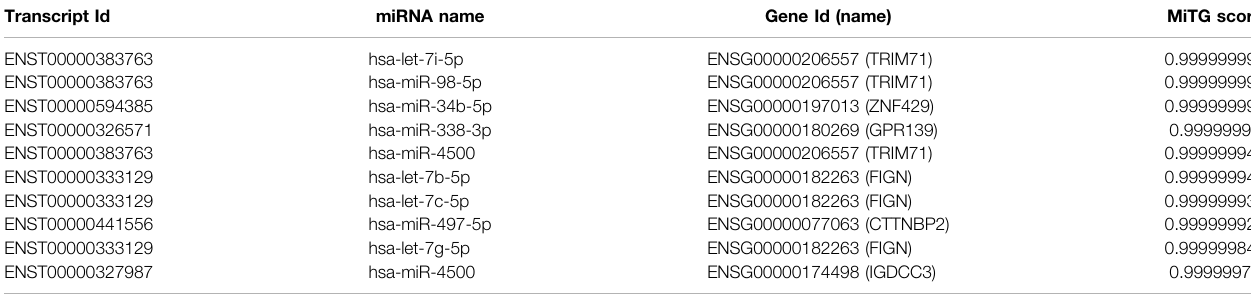
TABLE 2 | Targeted messenger RNAs (mRNAs) predicted by differentially expressed micro RNAs using the integrated data.